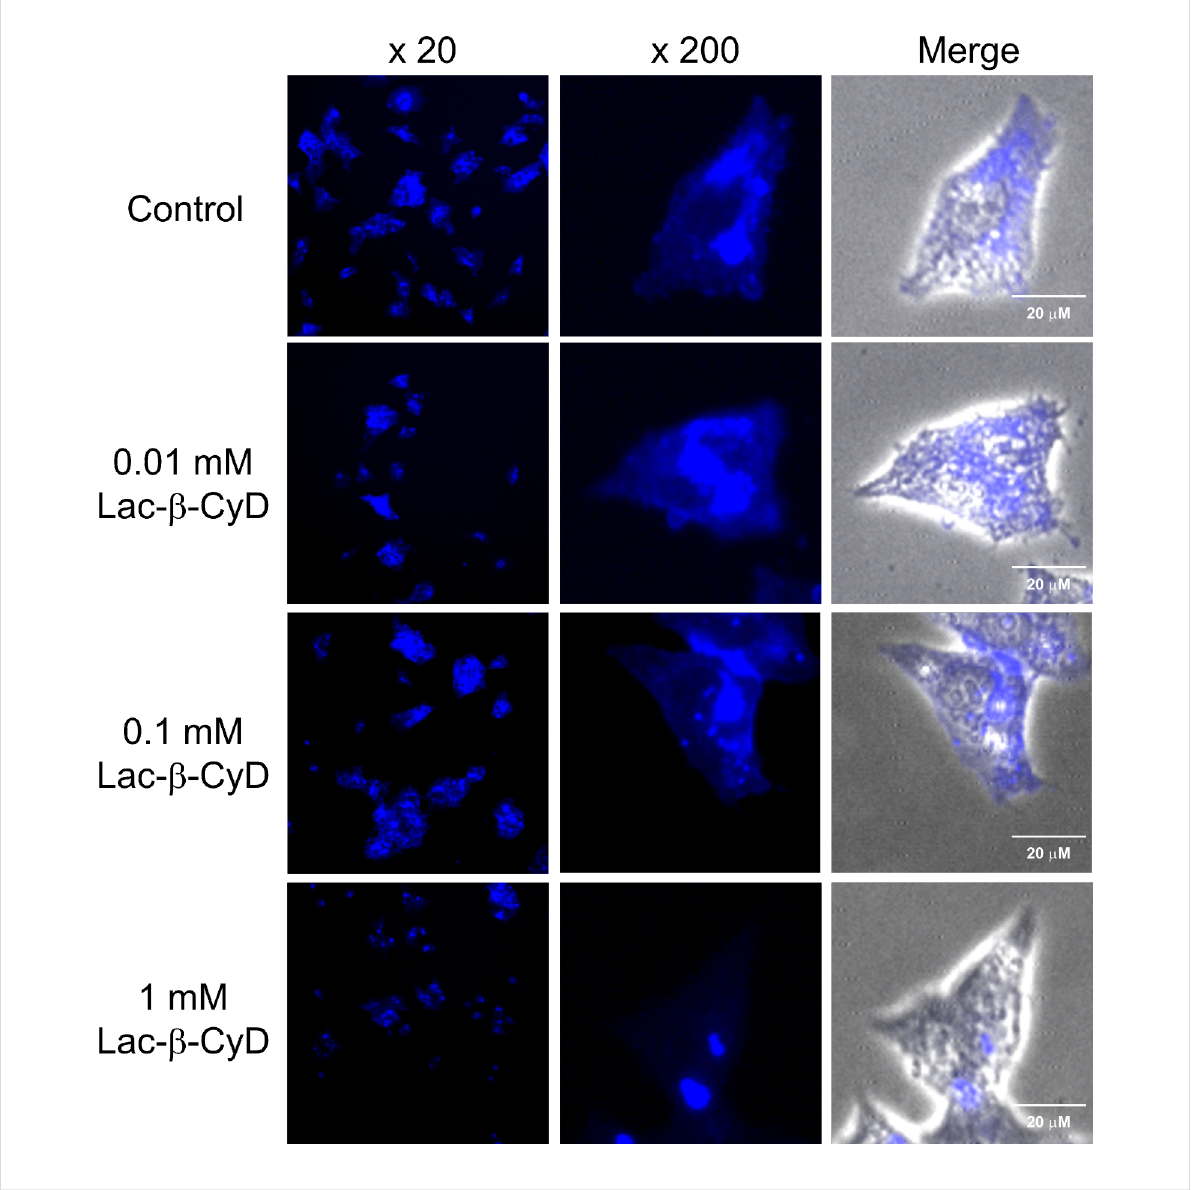
Figure 6: Effect of concentration of Lac- β -CyD on intracellular level of free form of cholesterol in U18666A-treated HepG2 cells. U18666A-treated HepG2 cells were incubated in medium (FBS ( − )) with or without Lac- β -CyD for 24 h. The experiments were performed independently three times, and representative images are